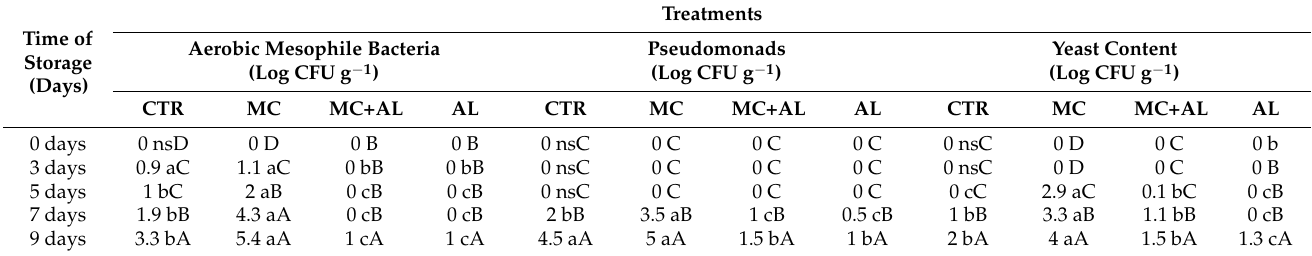
Table 5. Total mesophilic, Pseudomonads , and yeast content (Log CFU g − 1 ) in fruit slices of Actinidia deliciosa (Liang. Ferguson) coated with O. ficus-indica (OFI) mucilage (MC), or mucilage + A. arborescens MC+AL, or A. arborescens (AL) not treated (CTR), just after being coated (0) and at 3, 5, 7, 9 days of storage at 5 ◦ C. Different lowercase letters indicate significant differences between treatments at each sampling date. Different capital letters indicate significant differences between sampling date for the same treatment. Tukeys’ significant test was applied at p ≤ 0.05. Data are means ± S.E. ( n =